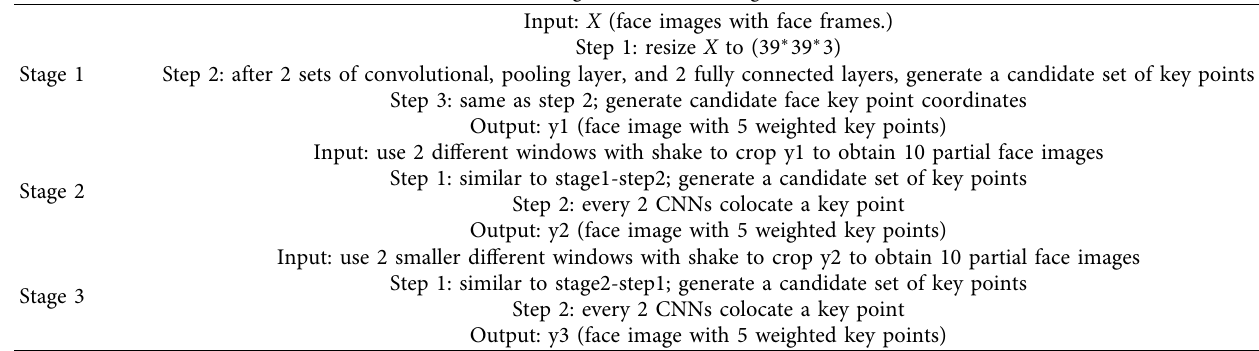
Table 1: Design of the CCNN